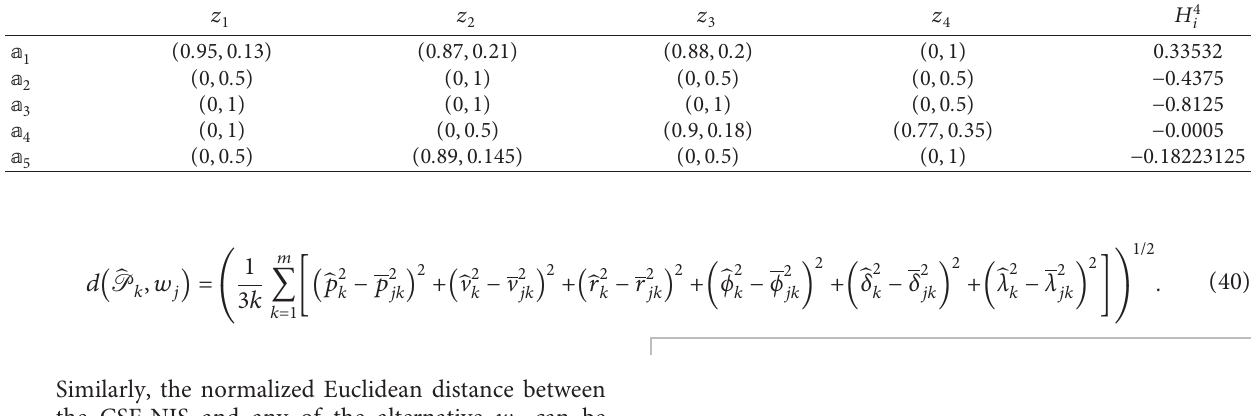
Table 38: Tabular representation of the PF 6 S z 1